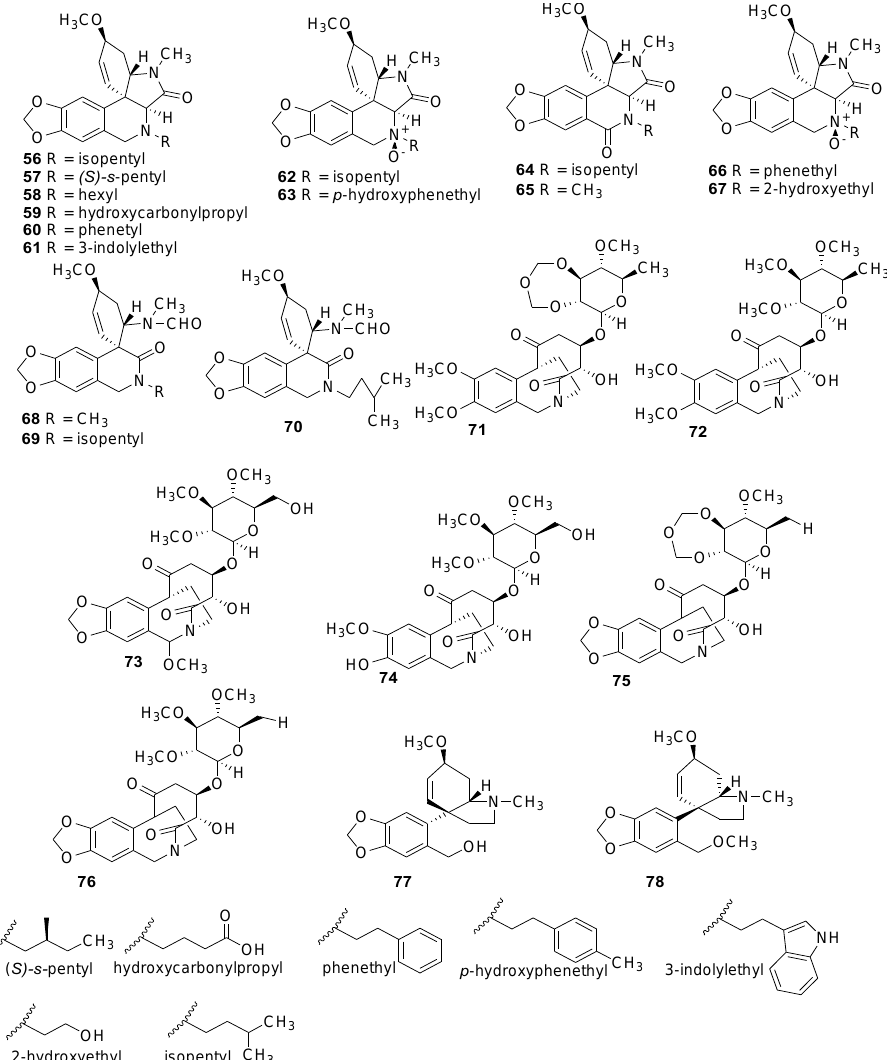
Figure 6. Chemical structure of new alkaloids plcamine-, seco -plicamine-, cripowellin-, and mesembrine-type. Numbers in bold refer to the compounds depicted in Table 2.